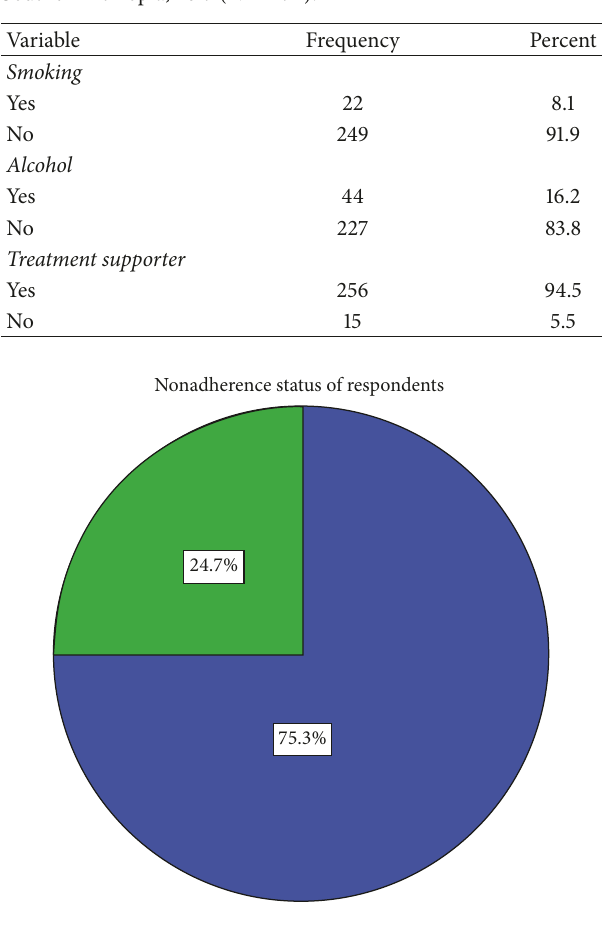
Table 2: Behavioral characteristics of the TB patients that attended TB clinics at governmental health institutions of Arba Minch town, Southern Ethiopia, 2017 (𝑁 = 271) .